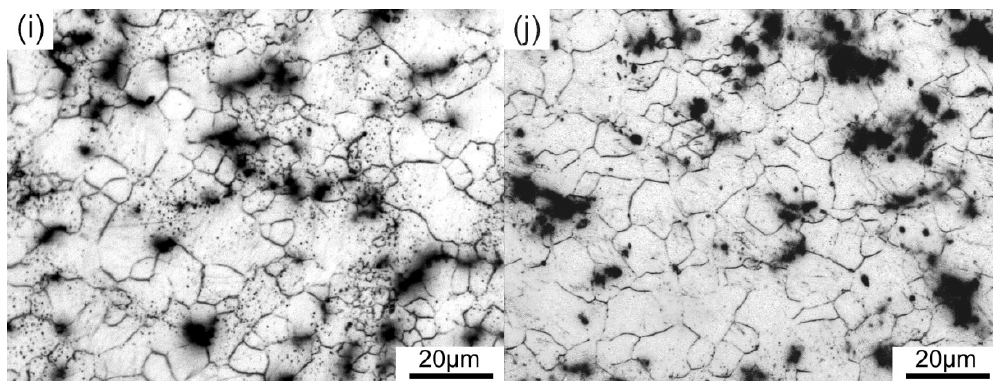
Figure 2. Optical micrographs of Mg-6Zn alloys: ( a ) as-extruded, and ECAP for ( b ) two passes at 160 °C, ( c ) four passes at 160 °C, ( d ) six passes at 160 °C, ( e ) two passes at 200 °C, ( f ) four passes at 200 °C, ( g ) six passes at 200 °C, ( h ) two passes at 240 °C, ( i ) four passes at 240 °C, and ( j ) six passes at 240 °C.